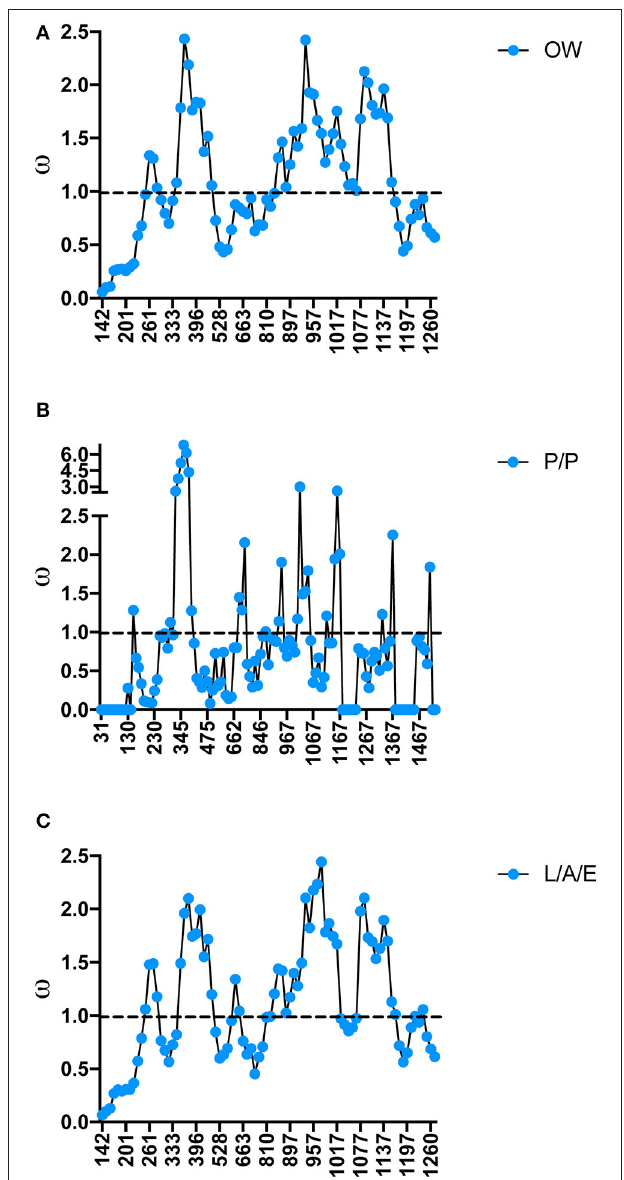
FIGURE 5 | Slide window analyses of omega ( ω ) for the salivary protein ParSP17 in all the sand fly species (A) , Old World sand flies (B) , Phlebotomus and Paraphlebotomus sub-genera (C) , and Larrossious, Adlerius, and Euphlebotomus sub-genera. Dotted lines point to the threshold for positive selection ( ω ≥